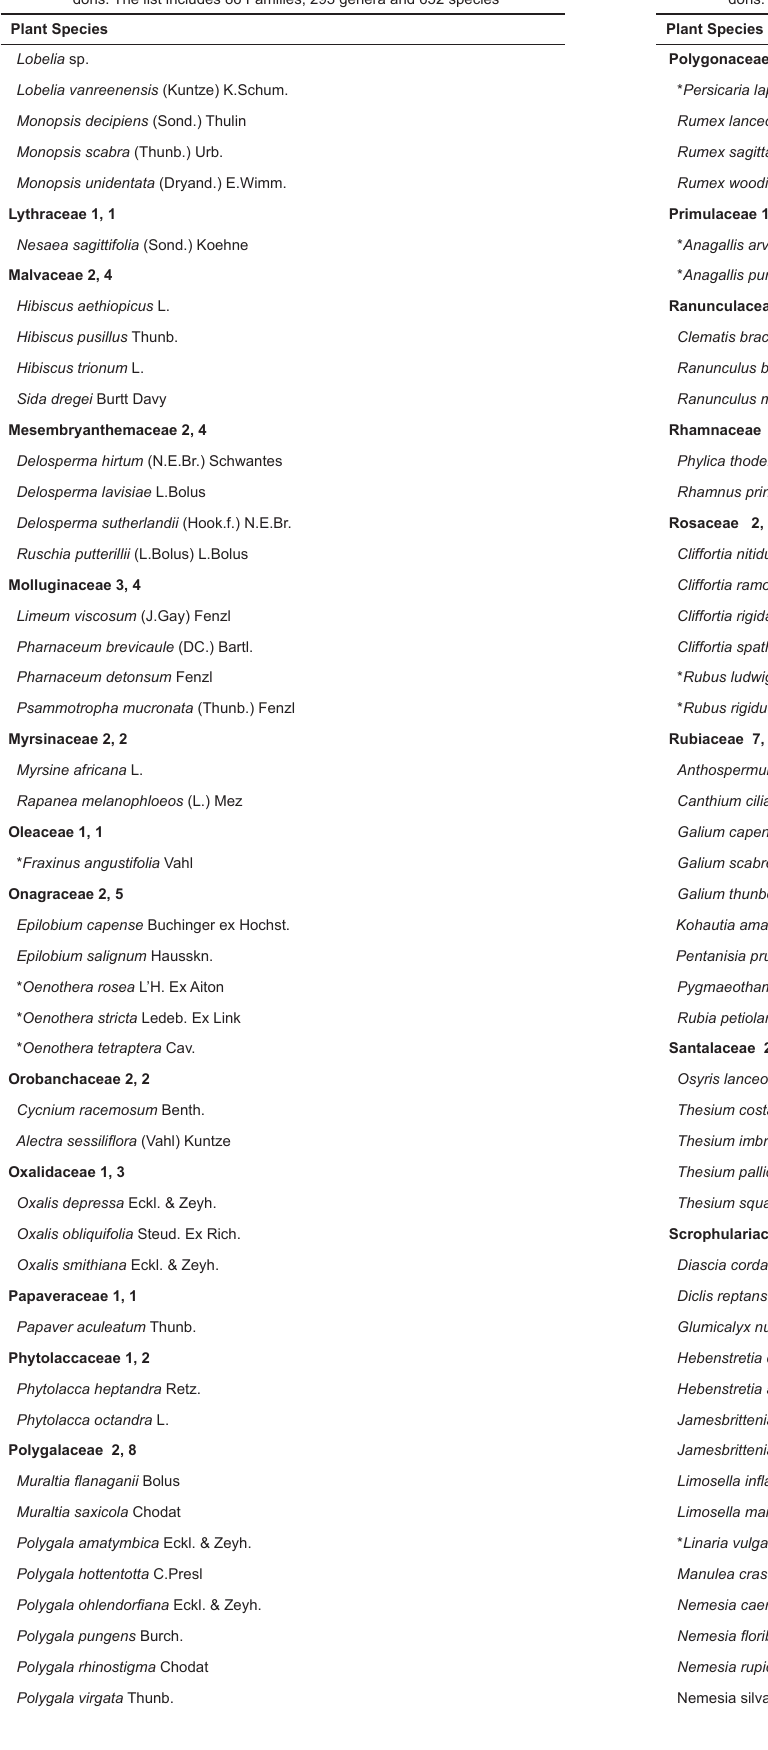
TABLE 4 (Continues...) Comprehensive list of Angiosperms, listed first by monocotyledons and then dicotyle - dons. The list includes 86 Families, 293 genera and 652 species